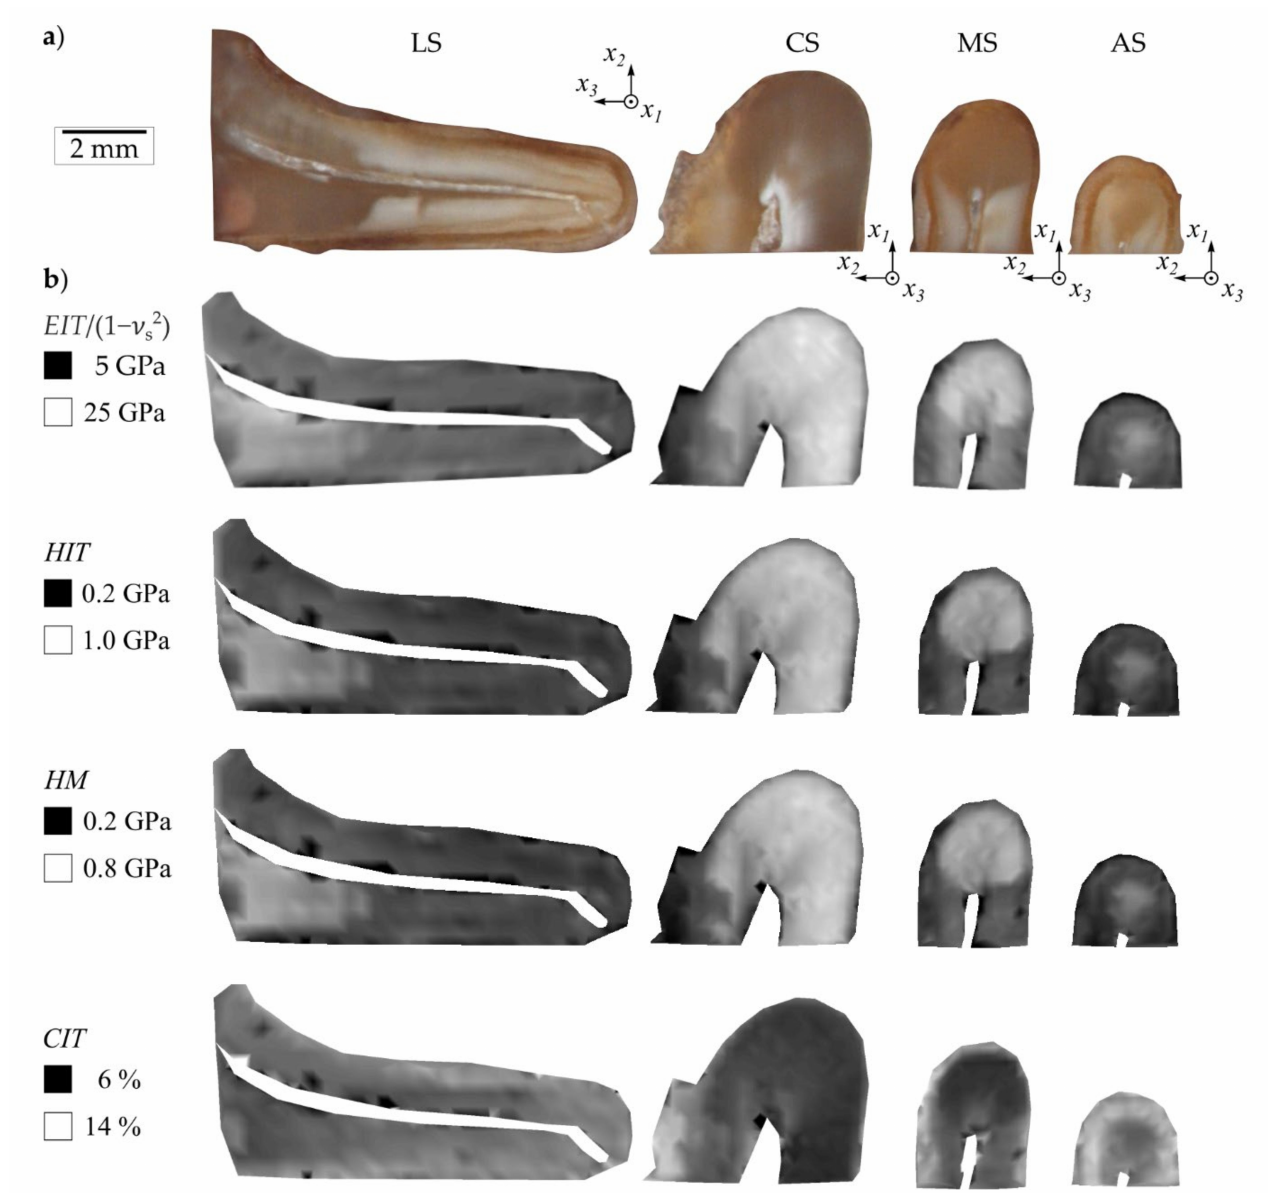
Figure 6. ( a ) Anatomy of mandibular first molar (longitudinal segment (LS), cervical segment (CS), medial segment (MS), apical segment (AS,) and ( b ) the related spatial distribution of mechanical properties: indentation modulus EIT , indentation hardness HIT , Martens hardness HM , indentation creep CIT